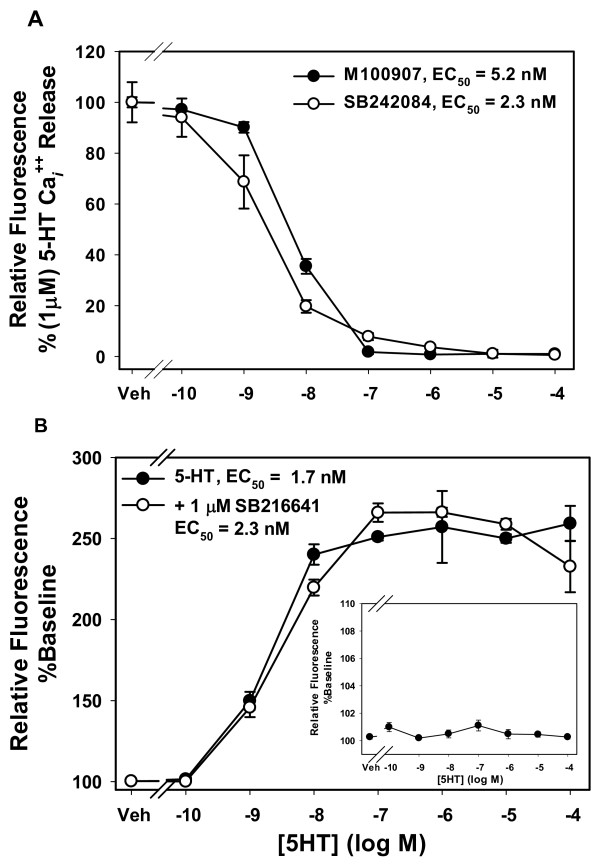
Effect of specific antagonists on Cai++ release. Cells were plated at 16,000 cells/well for 24 hrs, and loaded with Calcium 4 dye reagent. A. 5-HT2AR- or 5-HT2CR-CHO cells were preincubated with M100907 or SB242084, respectively, for 15 min then stimulated with 1 μM 5-HT. B. 5-HT2CR-CHO cells were preincubated with vehicle or 1 μM SB216641 for 15 min then stimulated with varying concentrations of 5-HT. Inset. Parental CHO-K1 cells (no preincubation) were treated with varying concentrations of 5-HT. n = 3-4 per group.